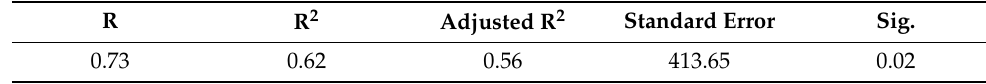
Table 9. Summary of models for mixed sites.